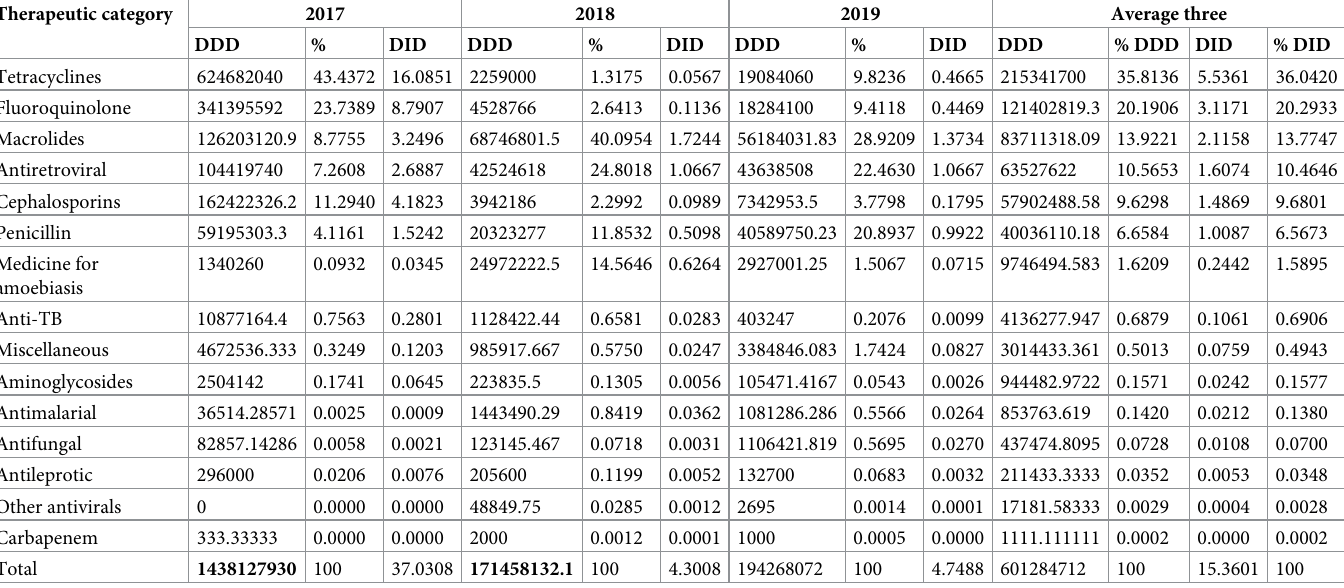
As shown in Table 3, antibacterial for systemic use (J01) comprised the vast majority of AMC each year, accounting for 91.86%, 58.9%, and 74.77% of the consumption in 2017, 2018, and 2019, respectively. Hence, antibacterials for systemic use accounted for an average of 87.03% Table 2. Summary of antimicrobial consumption in defined daily dose by therapeutic category from